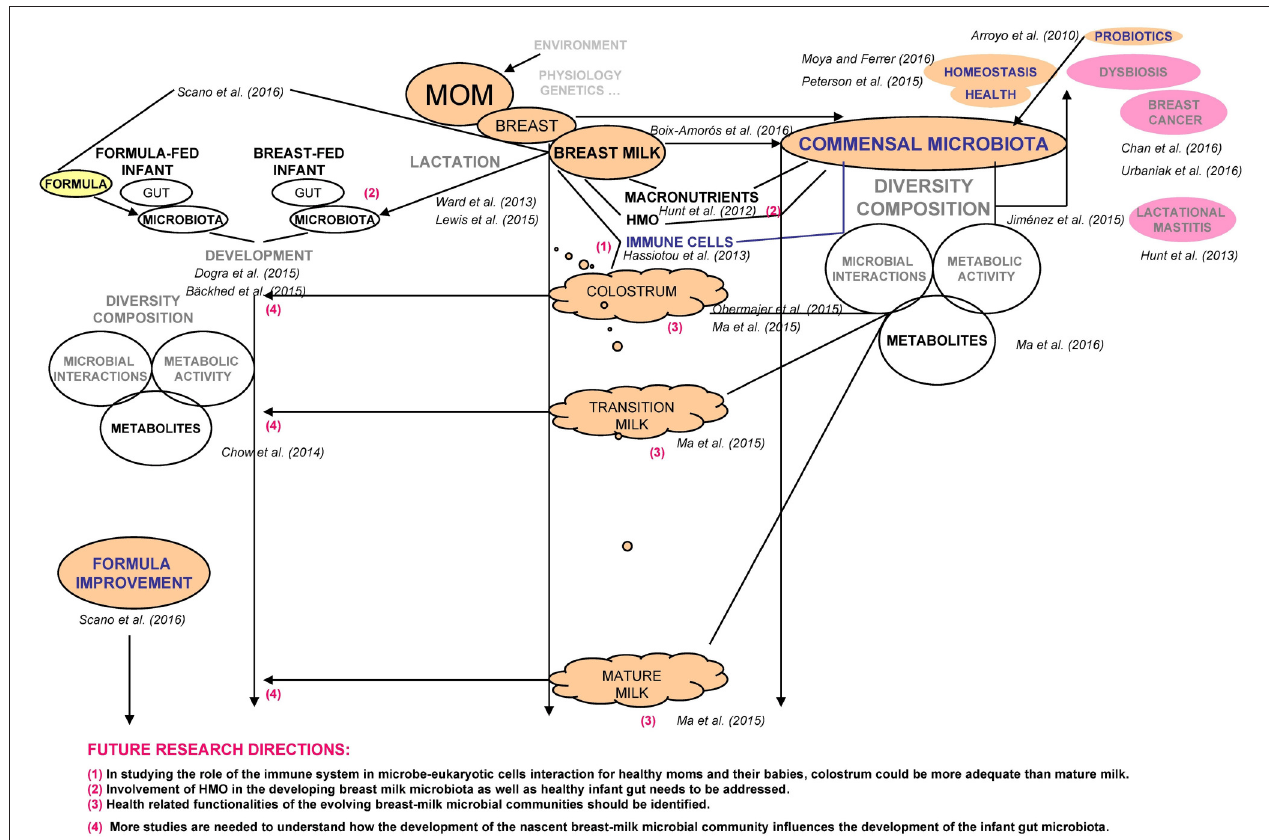
FIGURE 1 | Schematic presentation summarizing the discussed current research work and proposed future research